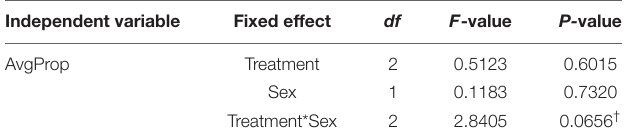
TABLE 4 | Statistical summary elucidating the effects of suboptimal incubation temperature on activity levels (Aim 3) using a global linear model